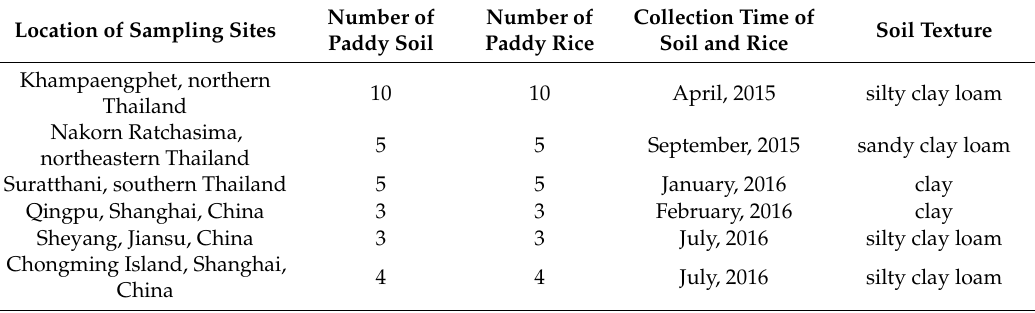
Table 1. The sampling sites, number, and time of surface soil and rice from Thailand and China. Number of Location of Sampling Sites Paddy